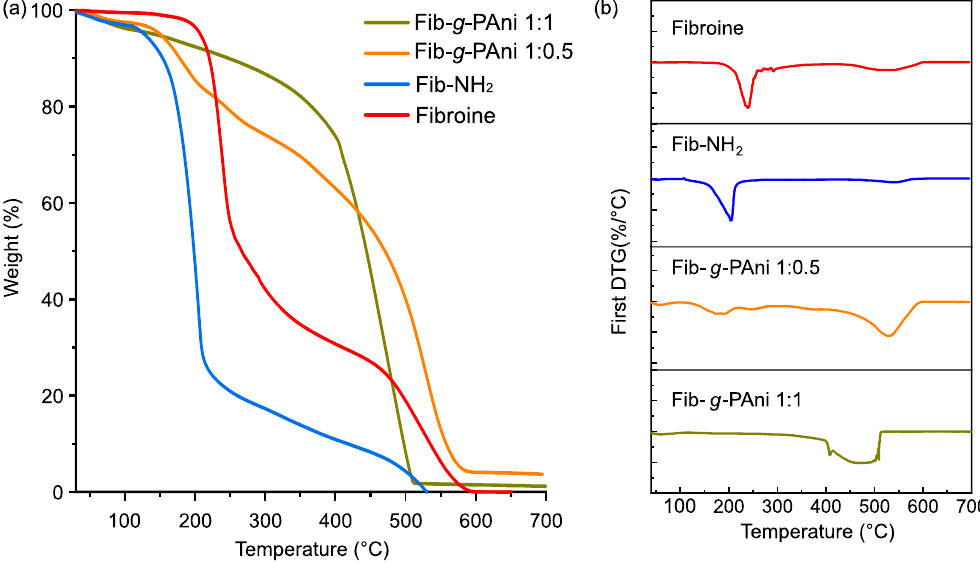
Figure 5. ( a ) Thermograms and ( b ) DTG of Fib, Fib-NH 2 , Fib- g -PAni 1:0.5 and Fib- g -PAni